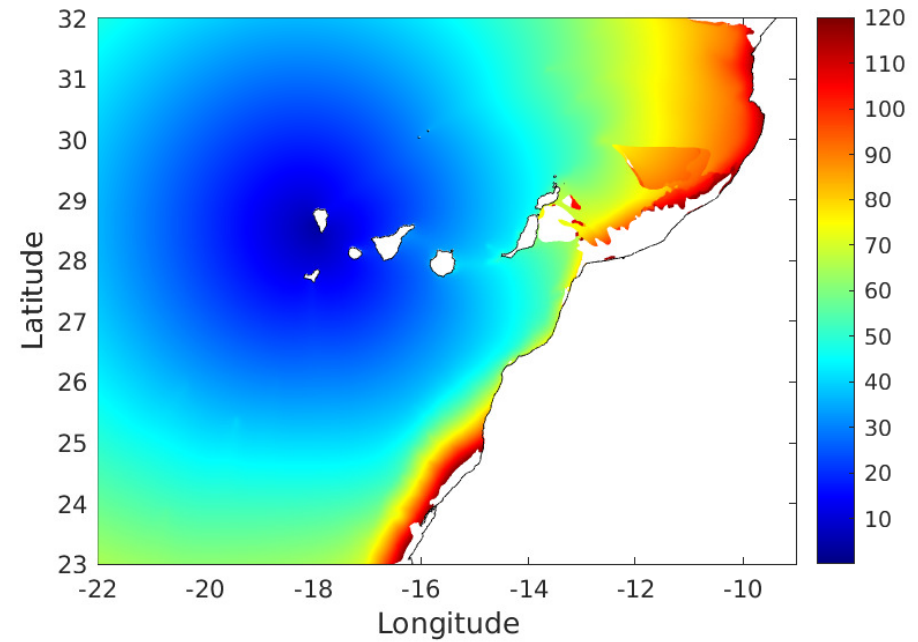
Figure 6. Calculated arrival time of a 1 cm signal (min) for a 4.5 km 3